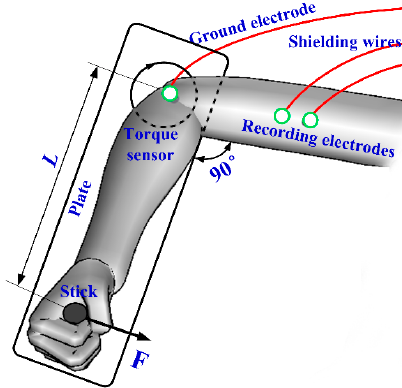
Figure 5. Schematic diagram of EMG measurement.